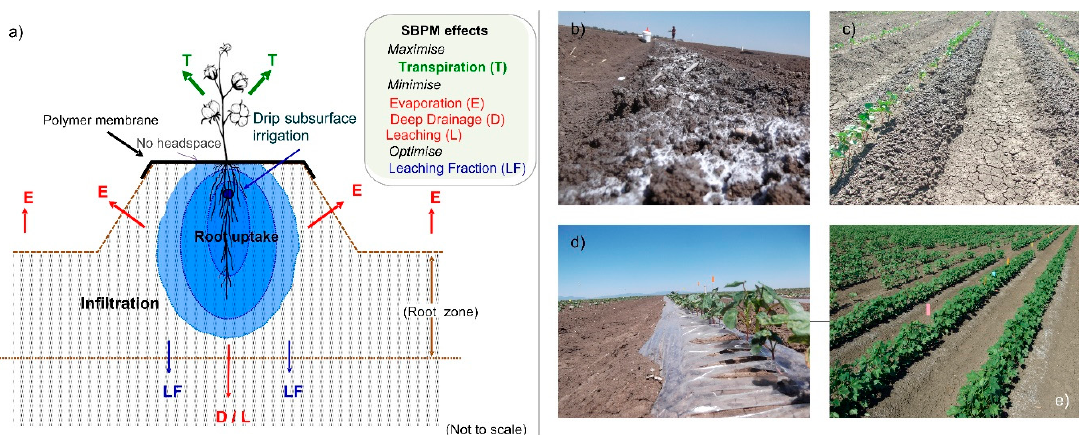
Figure 1. ( a ) Conceptual sketch of a sprayable biodegradable polymer membrane (SBPM)’s e ff ect on Figure 1. a) Conceptual sketch of a sprayable biodegradable polymer membrane (SBPM)’s effect on relatively small-scale soil hydrology. ( b ) Soil after the application of SBPM_full spray-on, ( c ) SBPM_gap relatively small-scale soil hydrology. b) Soil after the application of SBPM_full spray-on, c) SBPM_gap plot, ( d ) oxo-degradable plastic (ODP) slotted mulch film plot, ( e ) experimental layout in the plot, d) oxo-degradable plastic (ODP) slotted mulch film plot, e) experimental layout in the field